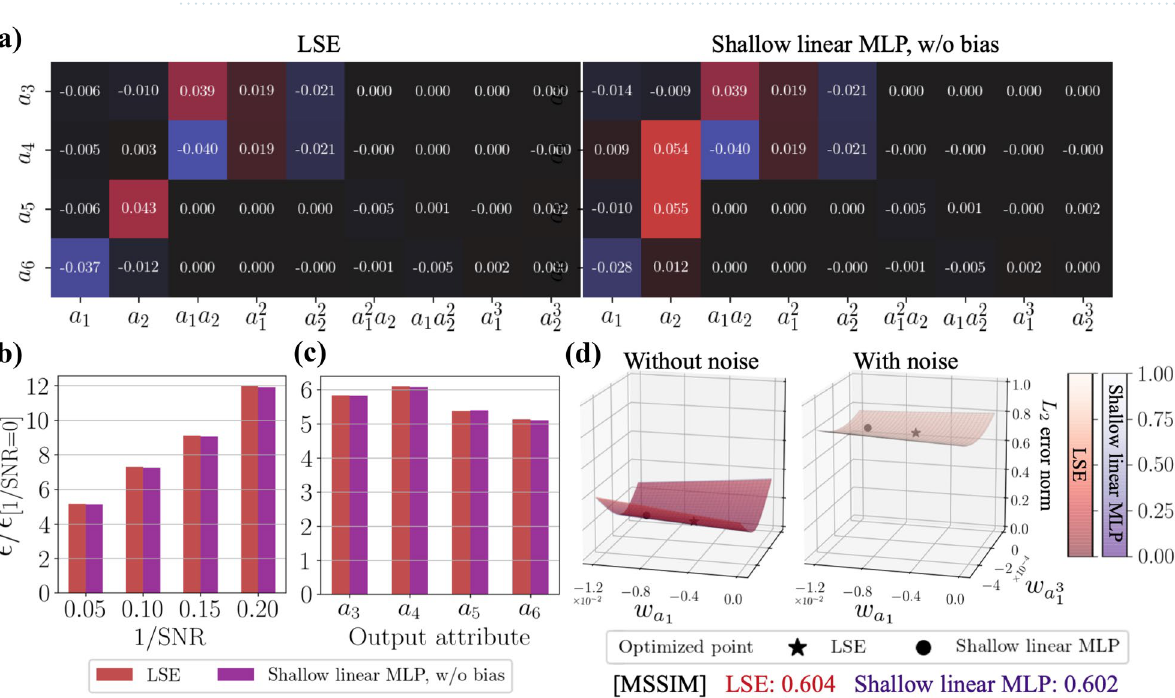
Figure 5. Comparison of the LSE and the linear MLP focusing on the bias and the optimization method. ( a ) Increasing ratio ε/ε [ 1 / SNR = 0 ] of the L 2 error norm ε from the original error ε [ 1 / SNR = 0 ] without the noisy input. ( b ) Weight values of the LSE and the shallow linear MLP. ( c ) Dependence of the increasing ratio ε/ε [ 1 / SNR = 0 ] of the L 2 error norm at 1 / SNR = 0.05 on the output POD coefficients. ( d ) Visualization of the error surface around the optimized point.